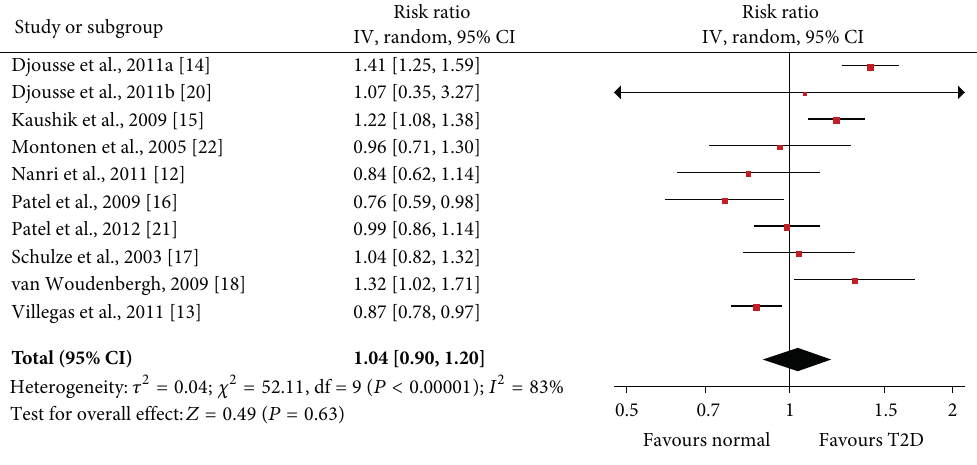
Figure 2: Forest plot of the meta-analysis for fish/seafood intake and incidence of type 2